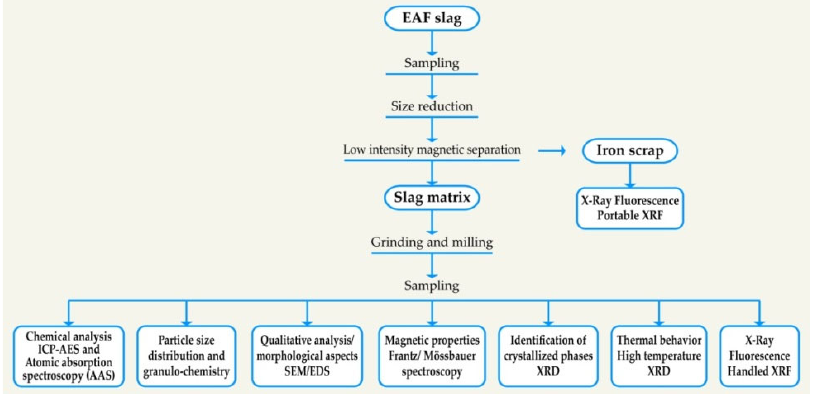
Figure 1. Experimental protocol for characterization of electric arc furnace (EAF) slag.